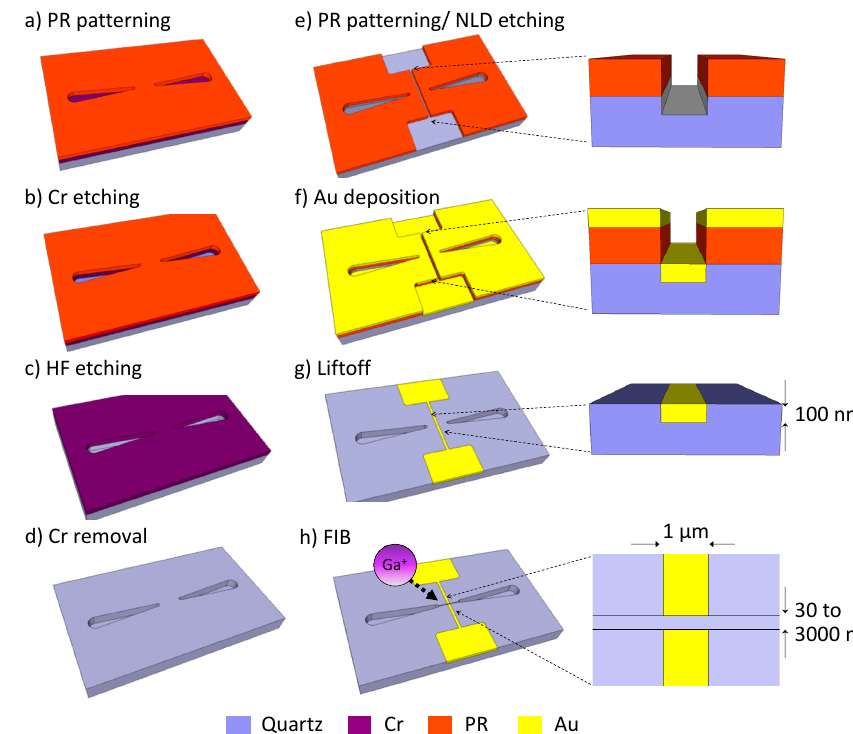
Figure 2. Fabrication of the measurement chip. ( a ) Photoresist (PR) patterning in preparation for the microchannel. ( b ) Etching of the Cr layer to create an etching mask to form the microchannel. ( c ) Hydrofluoric acid (HF) etching of quartz using the Cr layer as an etching mask. ( d ) Stripping of the Cr layer. ( e ) Patterning of the second photoresist followed by dry etching to create trenches for the electrode lines. ( f ) Deposition of the measurement electrode Ti/Au layers. ( g ) Stripping the photoresist layer to create the completely embedded Ti/Au electrode lines. ( h ) Simultaneous fabrication of the nanochannel and nanogap electrodes by focused ion beam (FIB) etching.